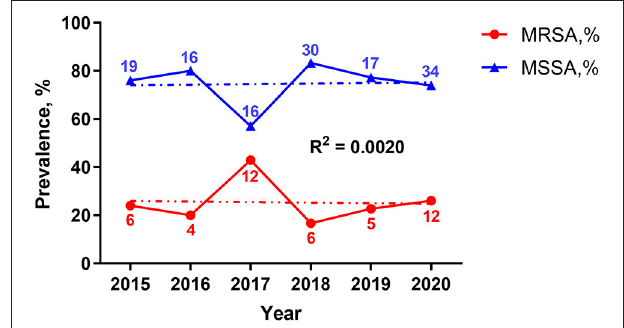
FIGURE 1 | Year-wise prevalence percentage of S. aureus isolates during 2015–2020. MRSA and MSSA are shown in red and blue, respectively. The lines represent the percentage of the two isolates per year. The numbers near the lines indicate the actual number of isolates in that year. Trend lines are shown as the dotted ones, with the correlation coefficient R 2 = 0.0020. MRSA, methicillin-resistant S. aureus ; MSSA, methicillin-sensitive S. aureus